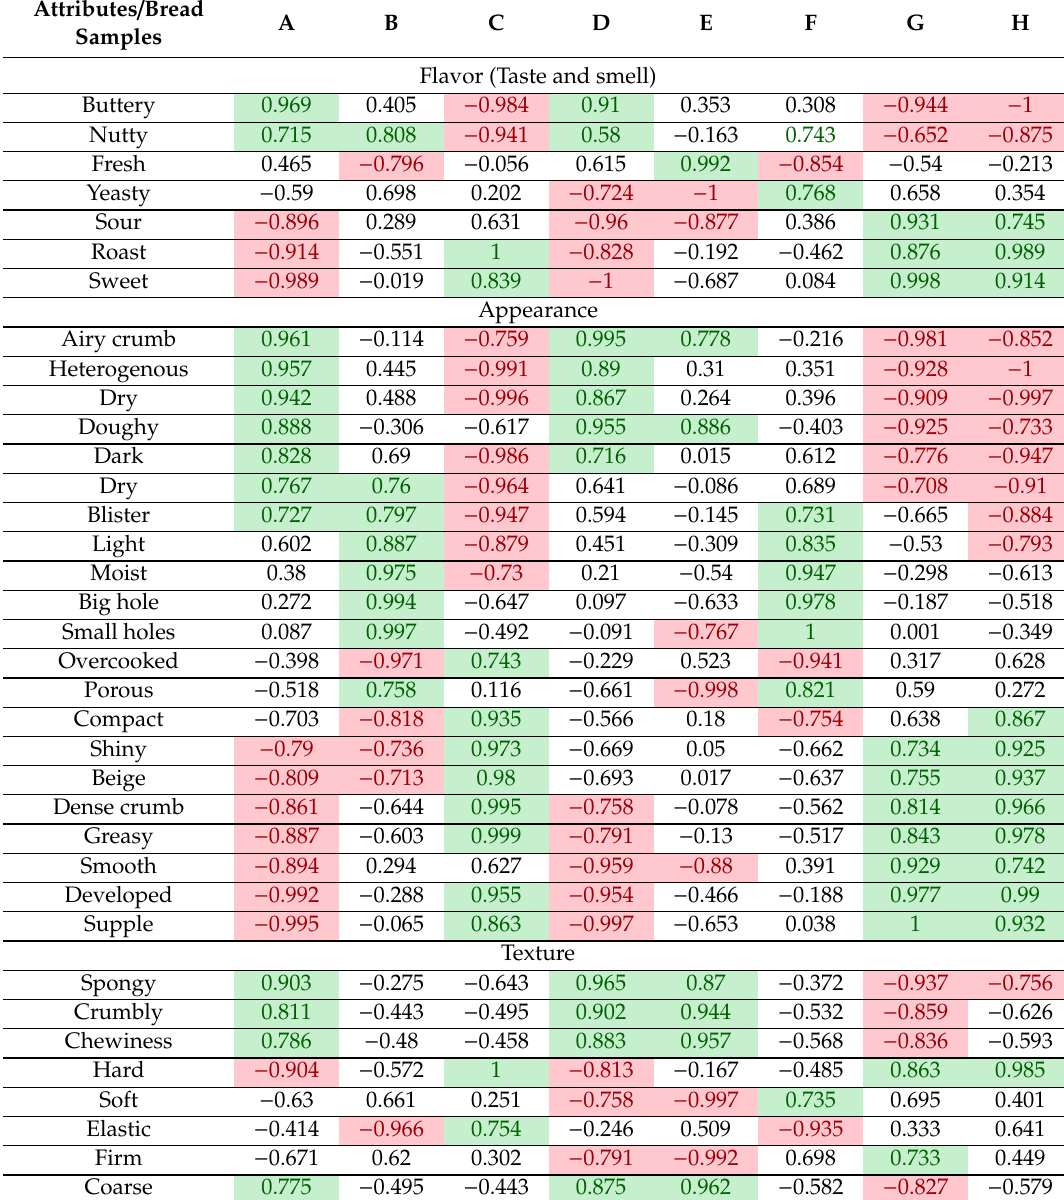
Table 6. Cosine values between bread product and the attributes used to describe the samples, obtained by Correspondence Analysis (CA) for eight sourdough bread samples using CATA questions. Attributes /